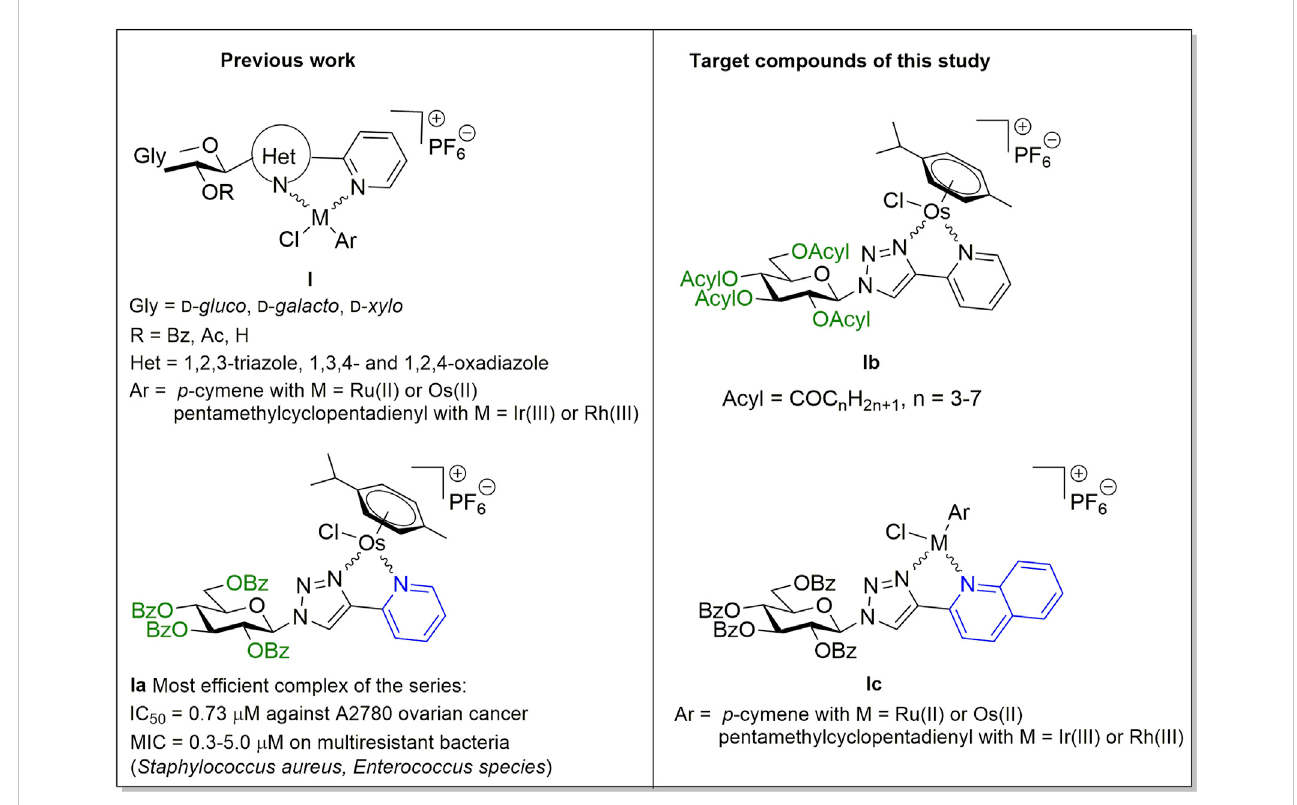
FIGURE 1 Preliminaries based on our previous studies (Kacsir et al., 2021; Balázs et al., 2022; Kacsir et al., 2022), and target compounds of this work.